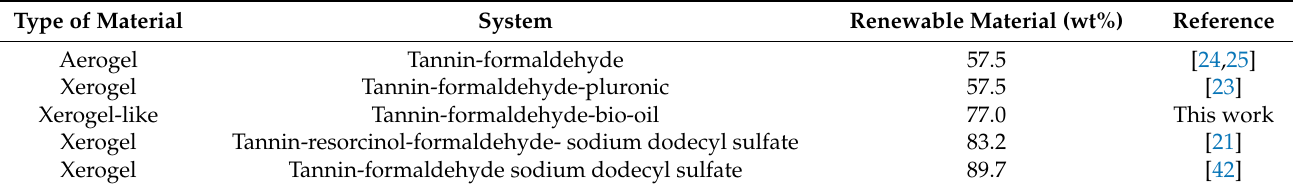
Table 2. Percentage of renewable materials in the tannin-formaldehyde gel system. Type of Material